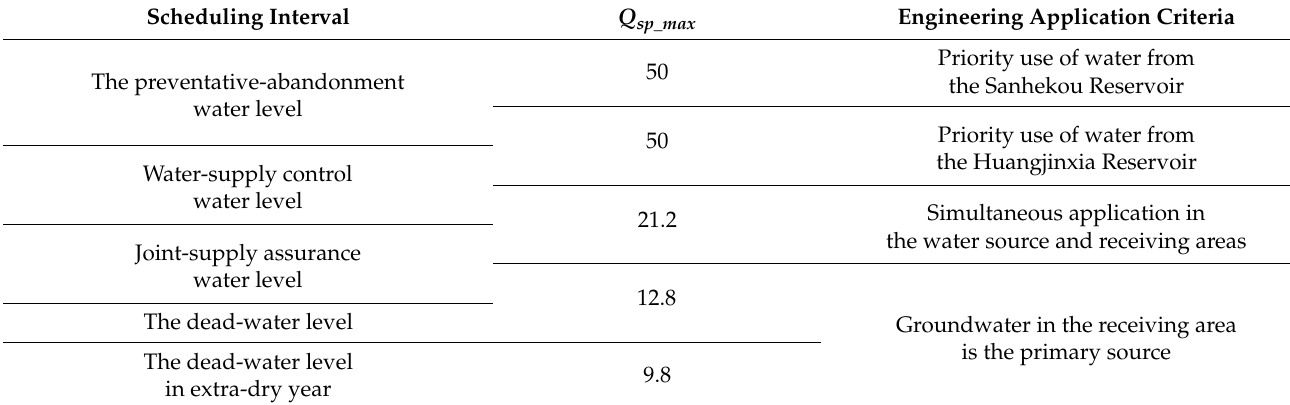
Table 1. Sanhekou Reservoir dispatching interval.